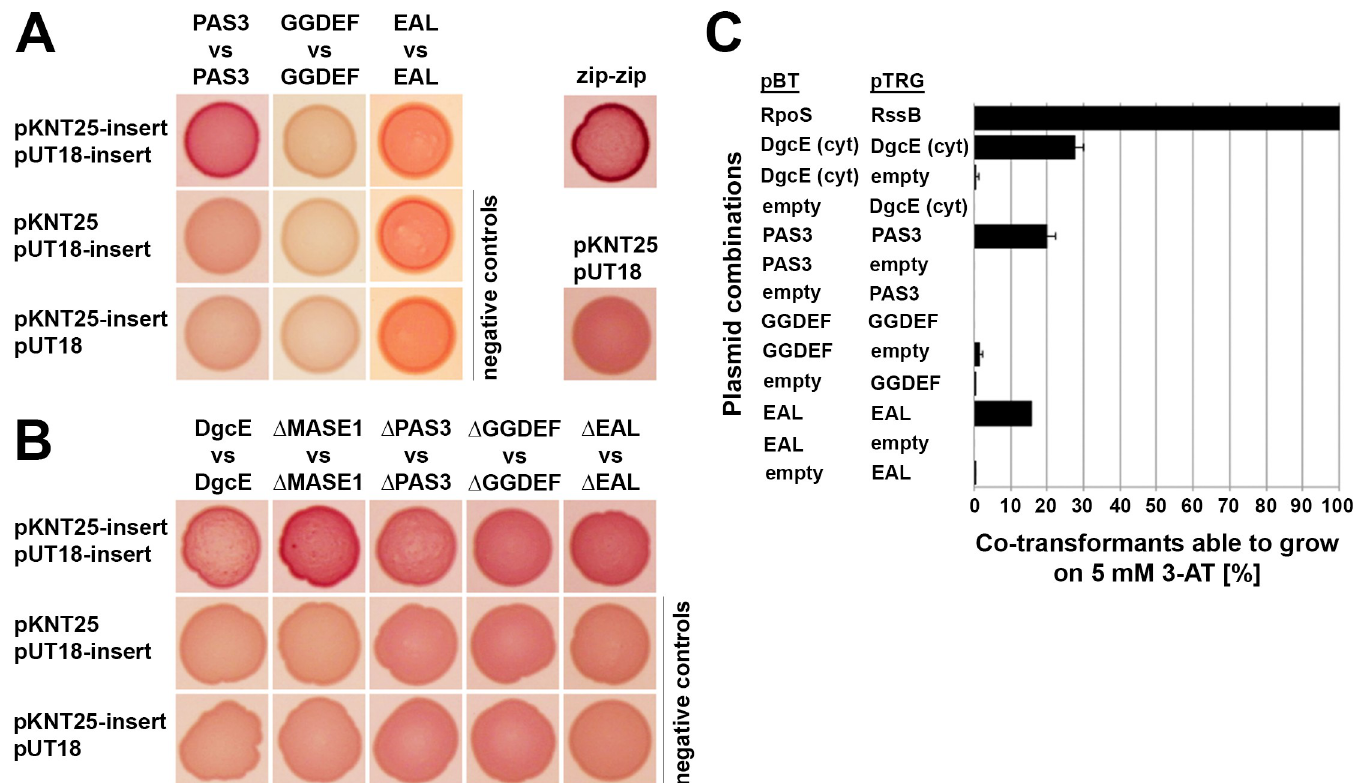
Fig 2. Role of distinct domains in DgcE dimerization. A: The isolated region containing all three PAS domains (PAS 3 ), as well as the isolated GGDEF and EAL domains of DgcE were tested for dimerization in adenylate cyclase-based two-hybrid assays. B: DgcE variants lacking specific domains as indicated were tested by two- hybrid assays. Spotted co-transformants were grown at 28˚C for 1 day. As a positive control, the leucin zipper part (’zip’) of the yeast GCN4 protein was used. Using pKNT25 and pUT18, the T25 and T18 fragments of adenylate cyclase are attached at the C-termini of the indicated isolated domains and the different DgcE variants. Two-hybrid plasmid vectors used in each combination are listed at the left side of the panels, with ’insert’ standing for the indicated proteins cloned into these vectors, vector names alone stand for the empty vectors in control combinations. C: The indicated parts of DgcE were tested for dimerisation using an alternative two-hybrid assay (Bacteriomatch; for details, see Materials and Methods). As a positive control, the strongly interacting RpoS and RssB proteins were used.